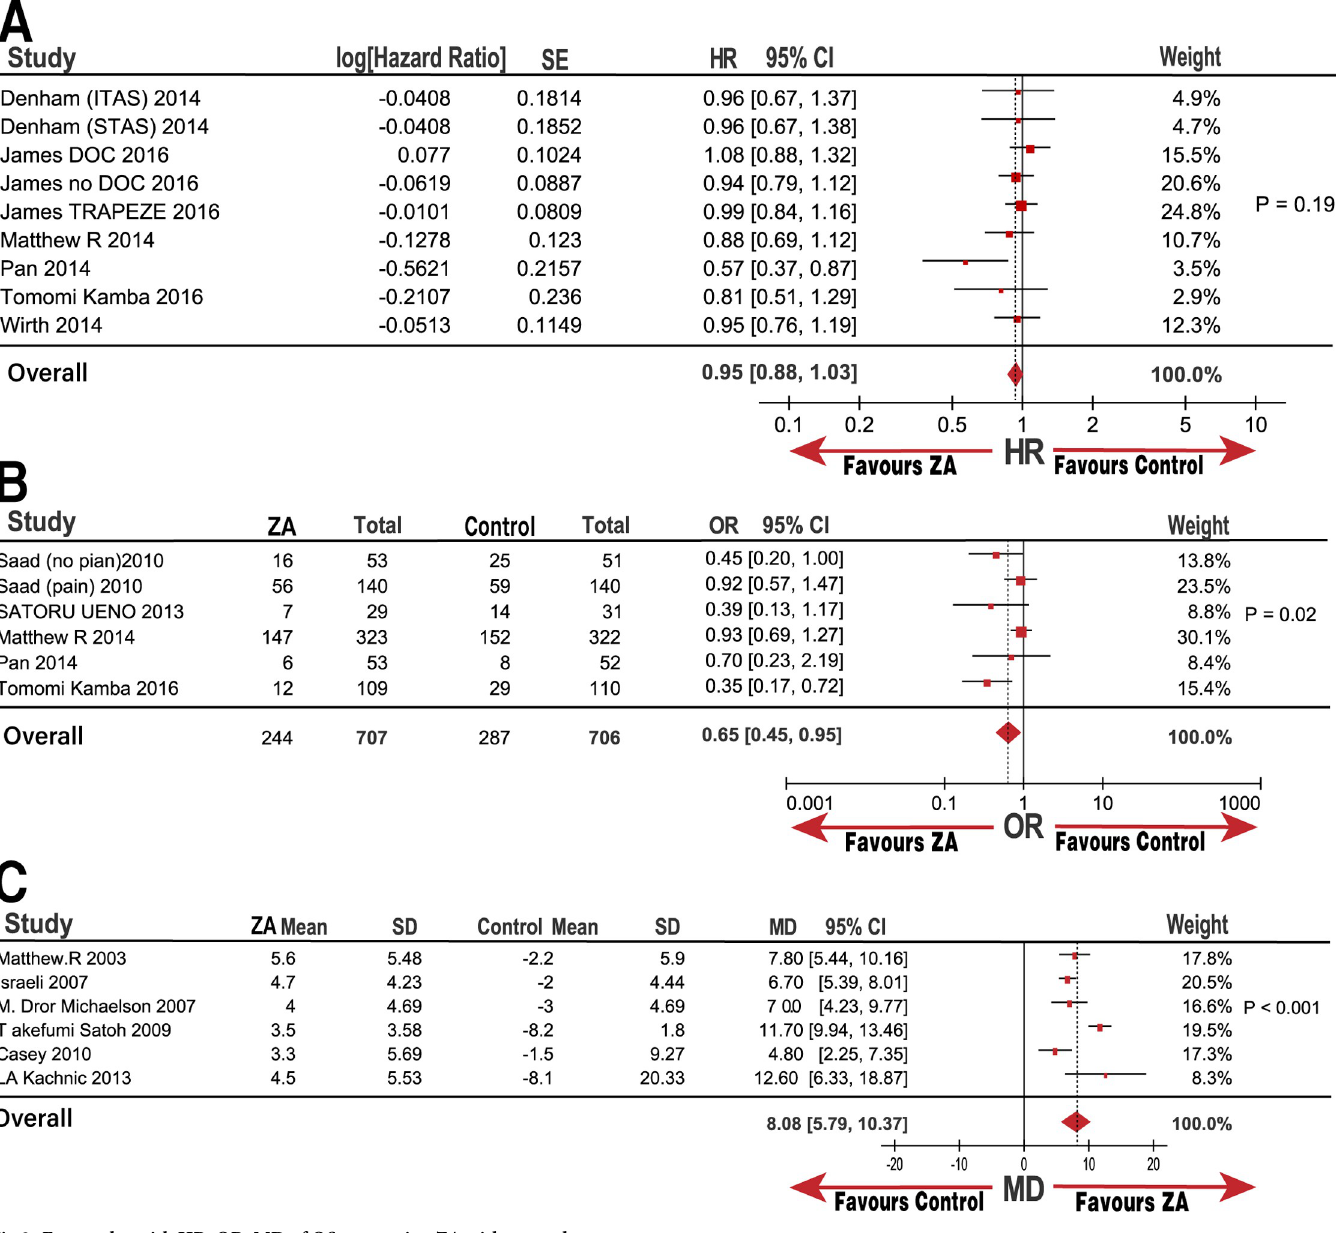
Fig 2. Forest plot with HR, OR, MD of OS comparing ZA with control